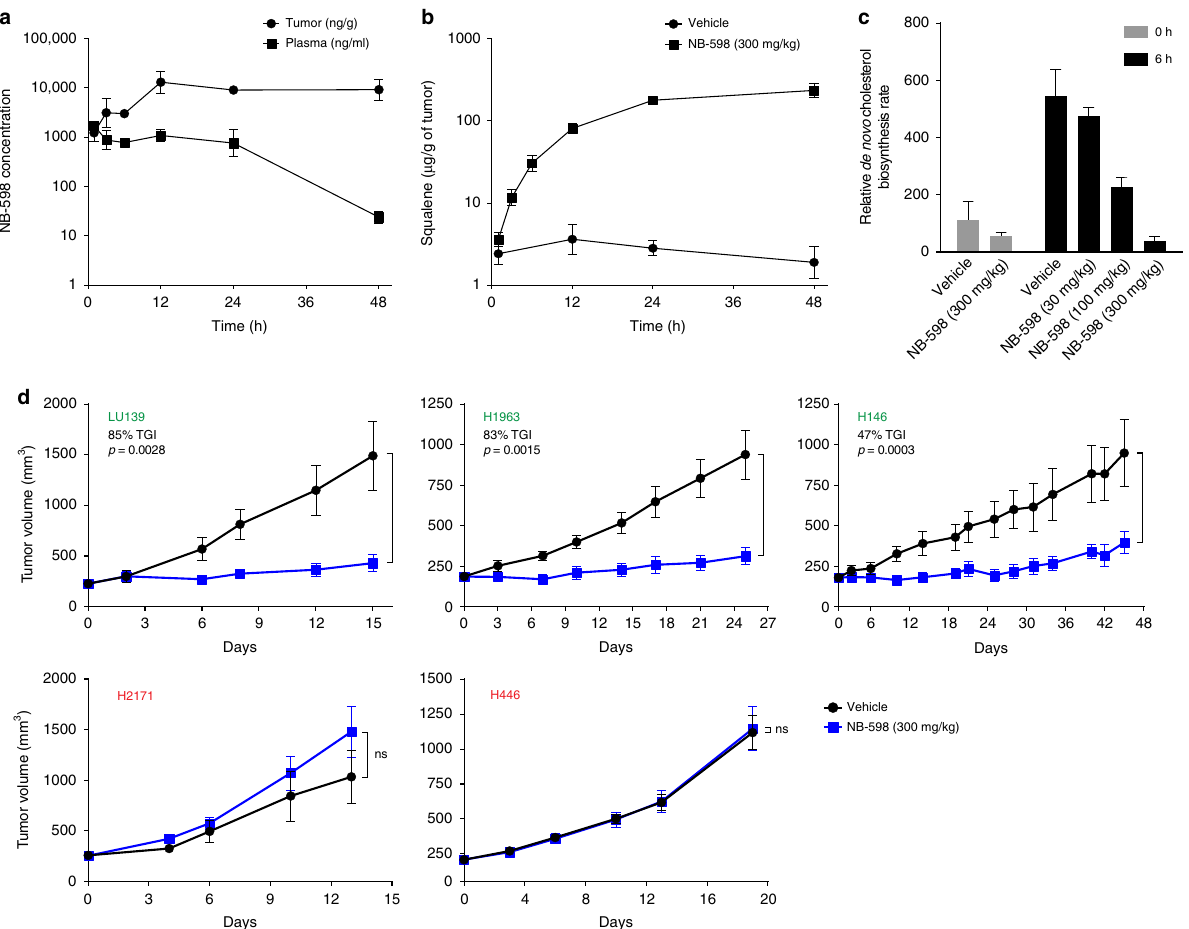
Fig. 3 In vivo translation of SQLE sensitivity in a subset of SCLC cell lines. a NB-598 single-dose (300 mg kg − 1 ) pharmacokinetic pro fi le in H146 xenograft- bearing mice. Mean values of triplicate measurements from a representative experiment are plotted and error bars represent s.e.m. b Squalene accumulation in H146 xenografts after a single dose of NB-598 (300 mg kg − 1 ). Mean values of triplicate measurements from a representative experiment are plotted and error bars represent s.e.m. c De novo cholesterol biosynthesis in tumors, as measured by deuterium enrichment in cholesterol after D 2 O labeling. Mean values of triplicate measurements from a representative experiment are plotted and error bars represent s.d. d In vivo ef fi cacy of NB-598 (300 mg kg − 1 ) dosed daily in multiple xenograft models. Dosing was initiated once tumors were approximately 200 mm 3 . SQLE-sensitive and SQLE- insensitive cell lines are denoted in green and red, respectively. Mean values of each experimental group ( n = 10 – 15 animals) from a representative experiment are plotted and error bars represent s.e.m. Student ’ s t test p values are shown and ns indicates p >